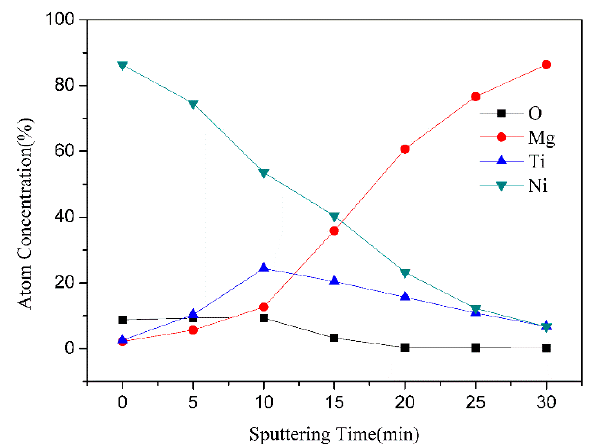
Figure 1. XPS elemental depth profiles acquired from the AM60 alloy after Ti / Ni ion implantation.